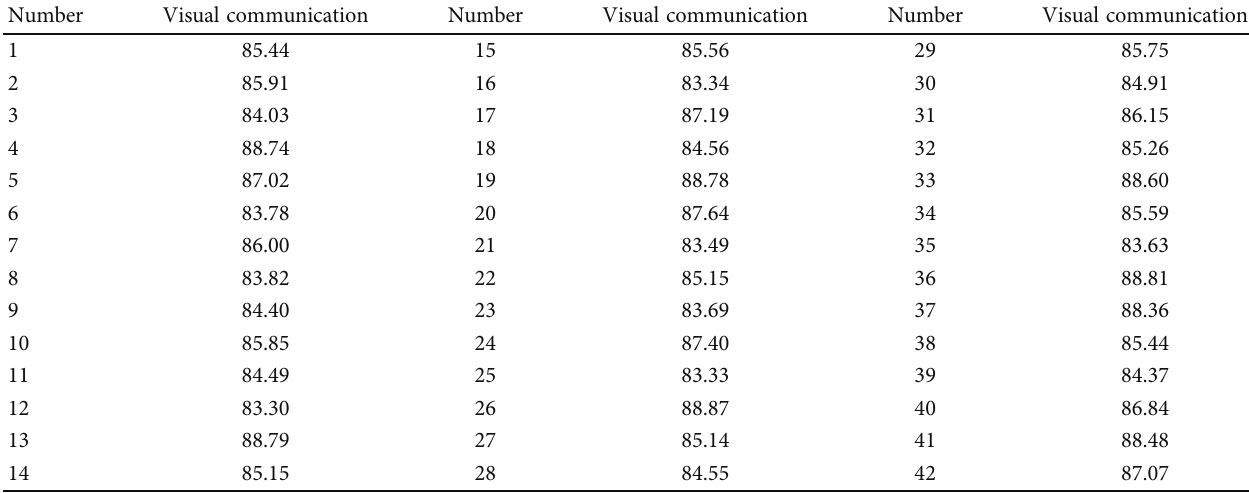
Figure 10: Optical path diagram of secondary recognition visual communication image (DT) in indoor simulation. Table 1: The research on diversi fi ed visual communication design based on computer digital